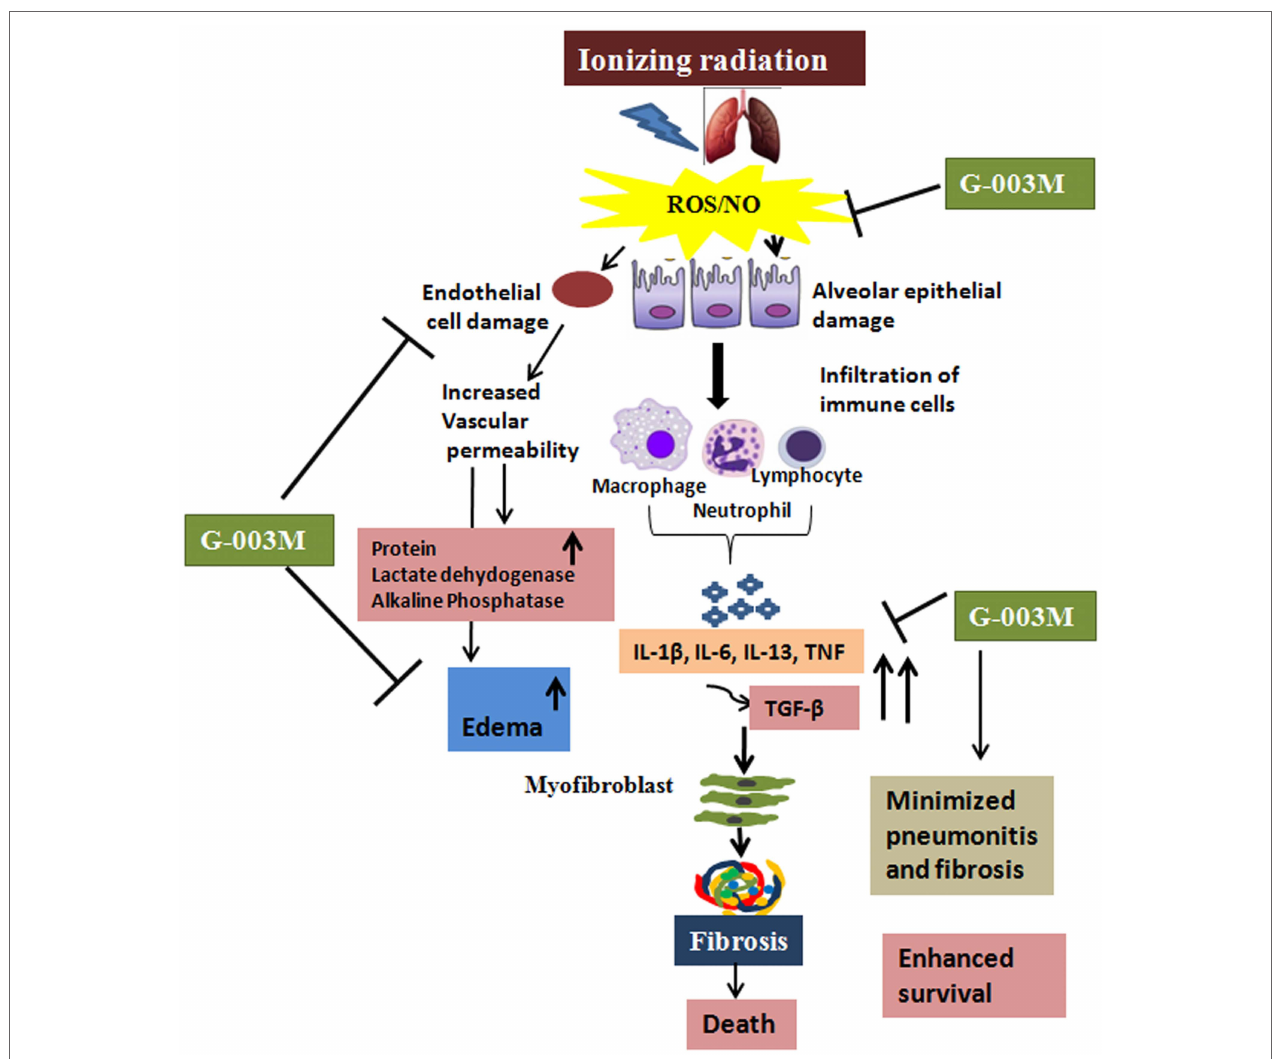
FigUre 9 | Diagrammatic illustration showing the possible mechanisms by which G-003M is reducing radiation-mediated pneumonitis and pulmonary fibrosis. Thoracic exposure to radiation results in rapid production of reactive oxygen species (ROS)/nitric oxide (NO), leading to epithelial and endothelial cell damage followed by extensive infiltration of the immune cells. Further increase in the pro-inflammatory and pro-fibrogenic cytokines leads to activation of myofibroblast, thus causing fibrosis and death. Administration of G-003M formulation stabilizes the highly reactive free radicals (ROS and NO), thus preventing the epithelial and endothelial cell damage and further infiltration of the immune cells. G-003M promotes survival against radiation by modulation of inflammation, immune response, and events leading to pulmonary